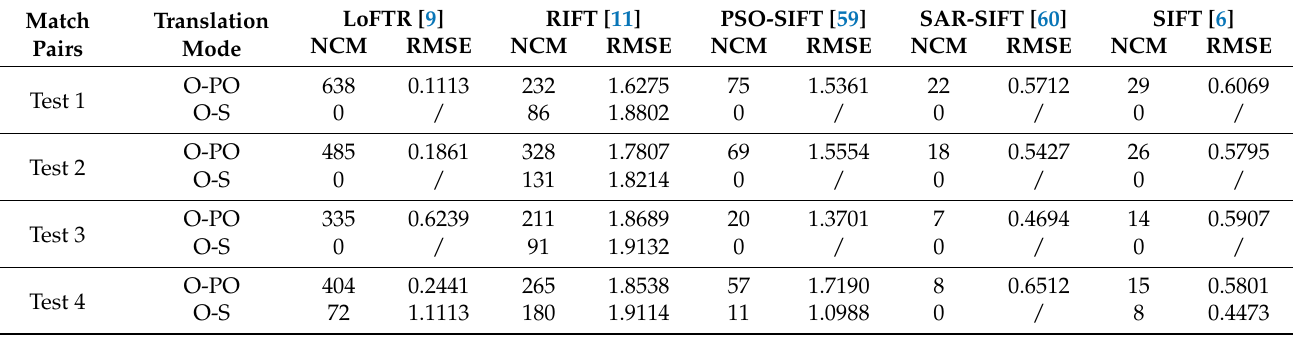
Table 5. O-PO: real optical images and generated pseudo-optical images; O-S: real optical images and real SAR images. Experimental comparison of O-PO and O-S matching performance under different matching methods.